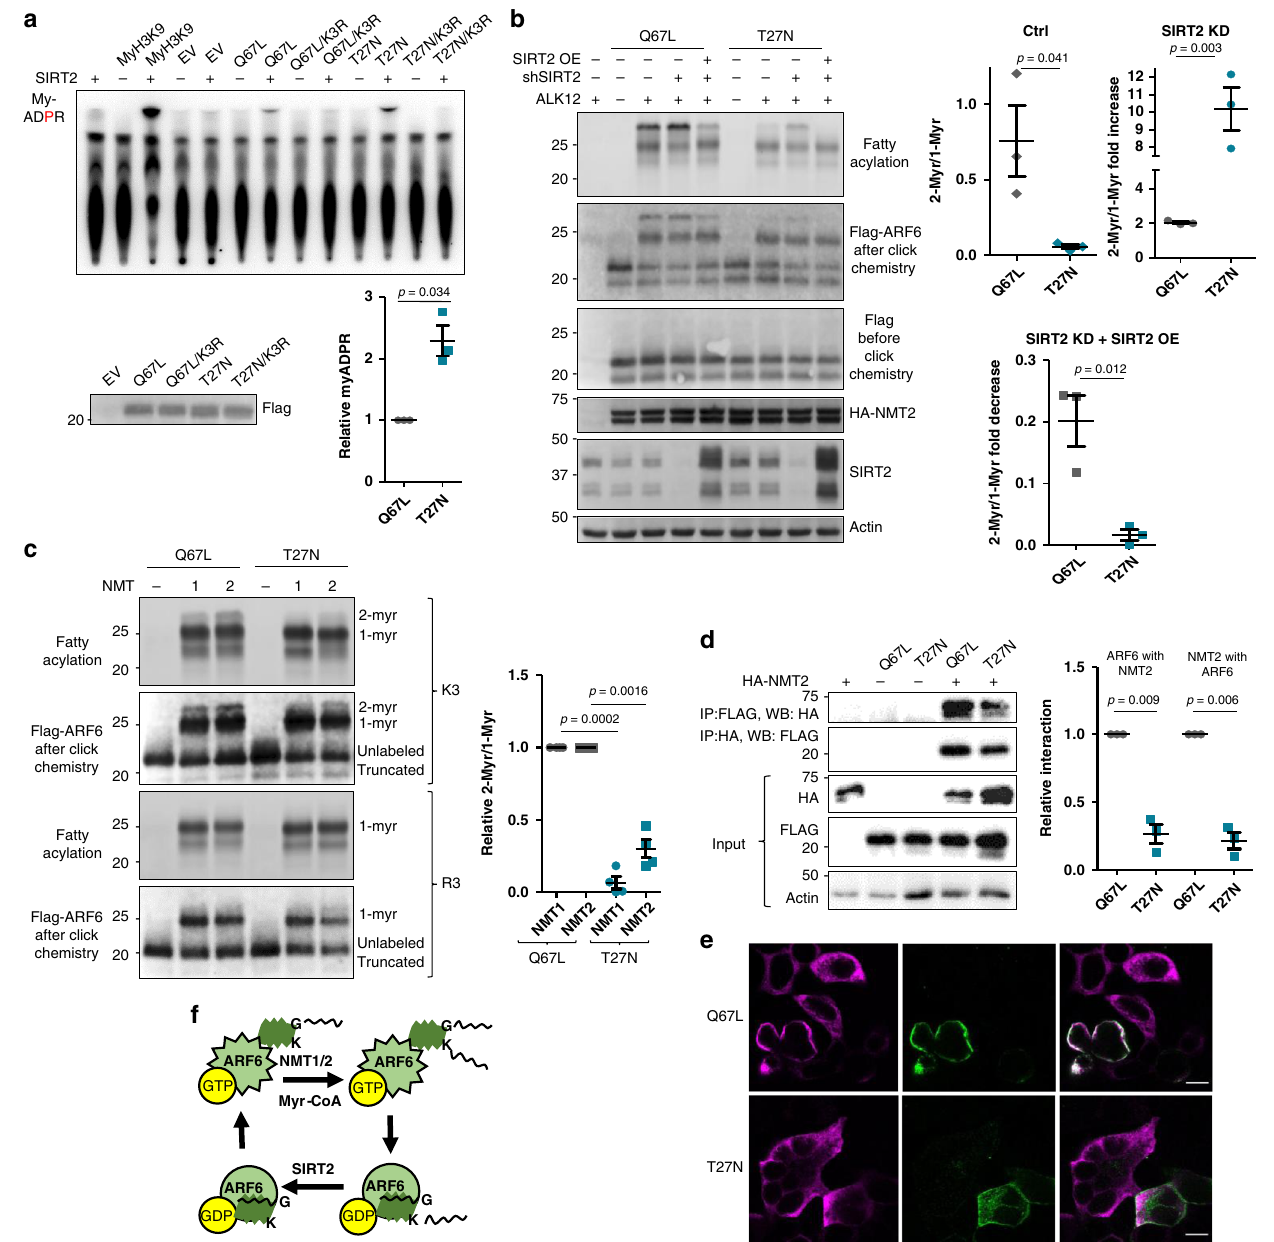
Fig. 5 Lysine myristoylation cycle is coupled to the catalytic cycle of ARF6. a SIRT2 removes more lysine myristoylation from ARF6 T27N than from ARF6 Q67L in vitro. ARF6 proteins were puri fi ed from cells with endogenous NMT and SIRT2 KD and subjected to the 32 P-NAD + assay with recombinant SIRT2. n = 3. b In-cell Alk12 labeling of ARF6 Q67L and T27N mutants during NMT2 OE showing more lysine acylation of ARF6 Q67L. n = 3. c In vitro NMT reaction on ARF6 Q67L and T27N showing more double acylation on ARF6 Q67L (ARF6-GTP). n = 4. d NMT2 preferentially binds ARF6-GTP. Flag-tagged ARF6 mutants and HA-NMT2 were overexpressed in HEK293T cells and subjected to the indicated pull downs. n = 3. e NMT2 is redistributed to the sites of ARF6 Q67L, but not ARF6 T27N. Confocal images of immuno fl uorescence in cells overexpressing FLAG-ARF6 mutants and HA-NMT2. Scale bars: 10 µ m. f Model showing that NMT acts on active, but SIRT2 on inactive ARF6. For all experiments, error bars represent SEM and n represents biological replicates analyzed by unpaired two-tailed t NMT inhibition or NMT1 KD (but not NMT2 KD) decreased, ARF6 T27N colocalization with TfR (Supplementary Fig. 10 and plasma membrane.